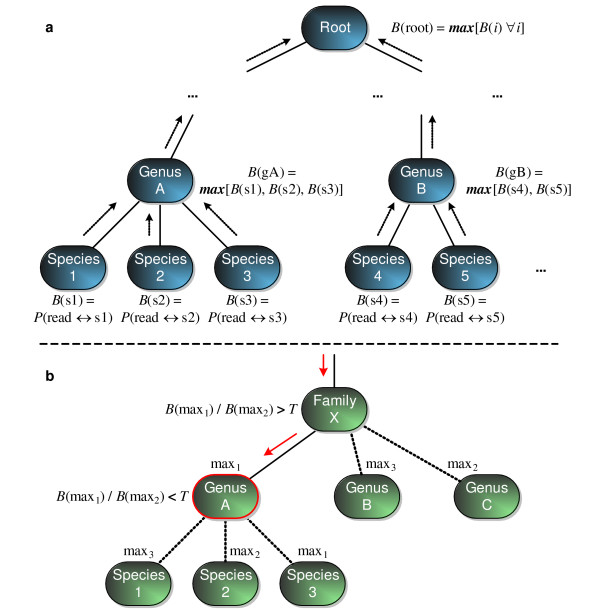
Placing read in phylogeny. Computing the most specific and confident placement of a read in the phylogenetic tree occurs in two stages. First, for each internal node we compute a score that is equal to the maximum of the scores of its children. Second, we traverse down the tree from the root until we find a node for which the child with the second maximum score is within a threshold T of the maximum score, or until we reach a leaf node.